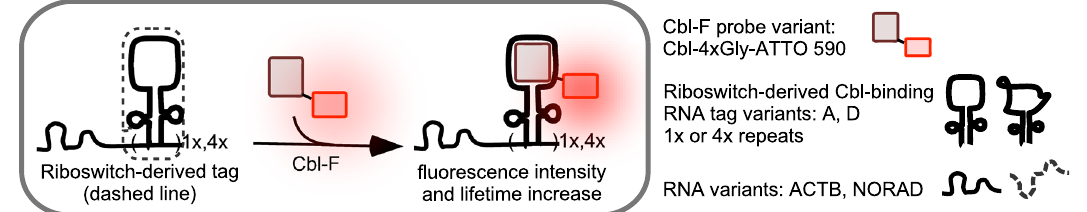
Fig. 1 | Visualizing RNAs in live mammalian cells using the modular Riboglow platform. Cobalamin (Cbl) is synthetically coupled to a fl uorophore (F) via an organic linker. Fluorescence of F is quenched by Cbl in the Cbl-F context. The Cbl moietybindstoaspeci fi criboswitch-derivedRNAsequence,inducing fl uorescence